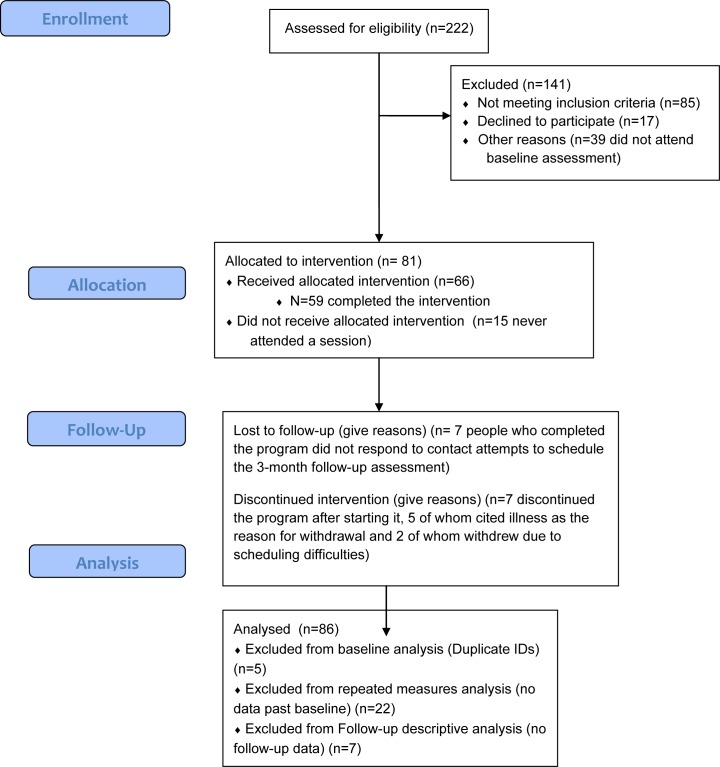
CONSORT diagram.